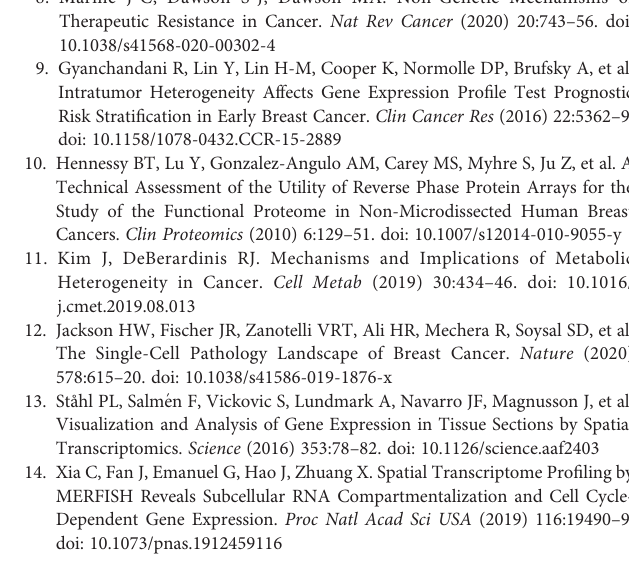
Supplementary Table 1 | Information concerning patients and type of tumors identi fi ed by the pathologist. Supplementary Table 2 | References cited in Table 2 and Figure 8D